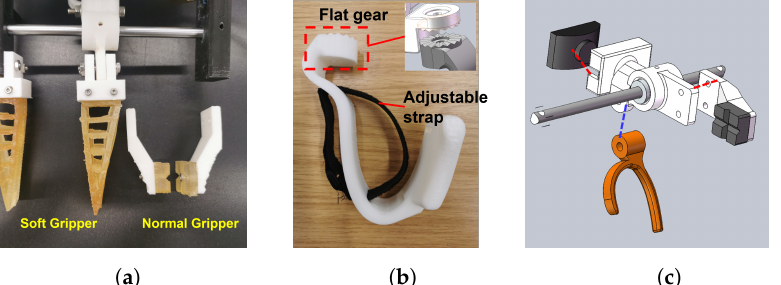
Figure 3. Three components of the exoskeleton. ( a ) Replaceable gripper tips. ( b ) C-shaped handle. ( c ) Semi-opened finger ring with its